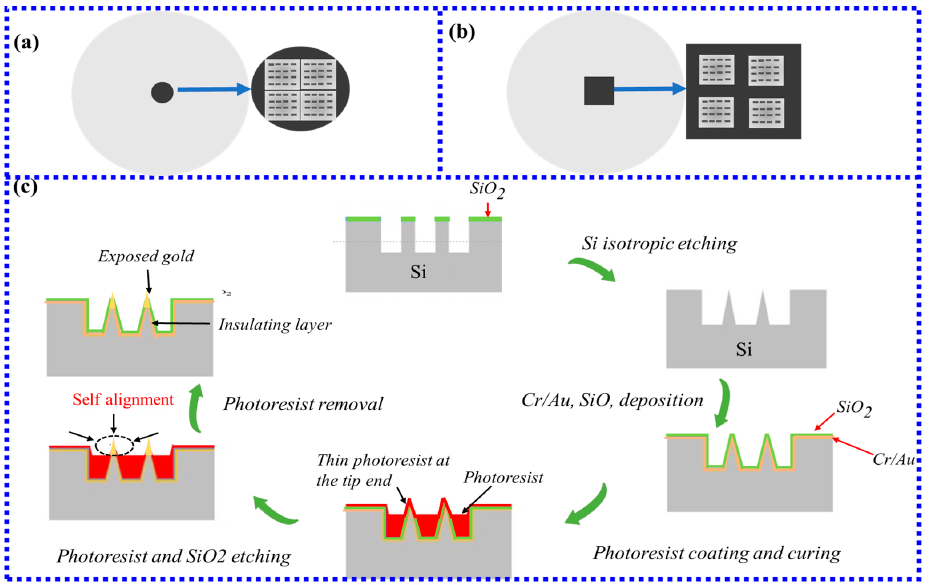
Figure 5. ( a ) Periodic arrays of FIB fabricated gold nanopillars on the cleaved end-faces of four- mode optical fibers; ( b ) Arrays of square nanopillars on the tip of a multimode optical fiber. ( c